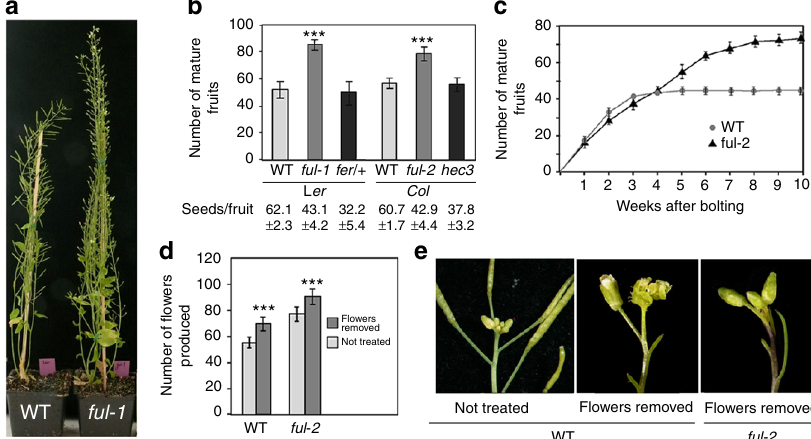
Fig. 1 FUL regulates GPA timing. a ful mutants produce more fruits than WT. b The increase in the number of fruits produced by the main in fl orescence in ful mutants does not depend on the genetic background or on the reduced seed production of ful fruits, since other mutants with similar reduced fertility (like hec3 or fer/ +) undergo GPA-like WT. Asterisks (***) indicate a signi fi cant difference ( P < 0.001) from WT according to Student ’ s t test. c ful mutants produce more fruits because GPA is delayed and the period of fruit production is extended. d Induced sterility by continuous manual pruning of developing fl owers causes increased fl ower production in WT and ful mutants. Asterisks (***) indicate a signi fi cant difference ( P < 0.001) from the corresponding untreated plants according to Student ’ s t test. e While sterility in WT leads to the formation of a terminal fl ower, in ful mutants sterility only leads to a further delayed GPA. n = 10 for all genotypes in b , c ,